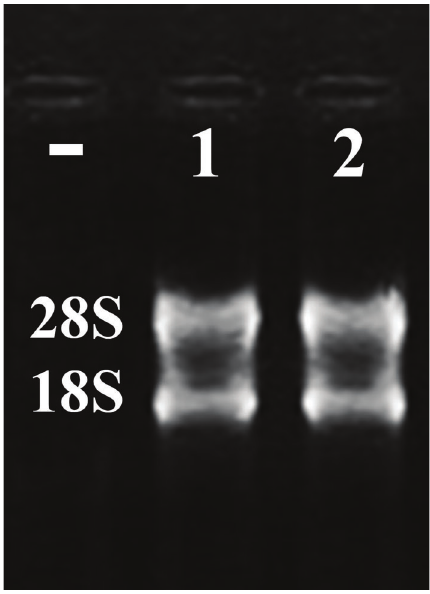
Figure 1. Samples of the extracted total RNA from the Kermani sheep.